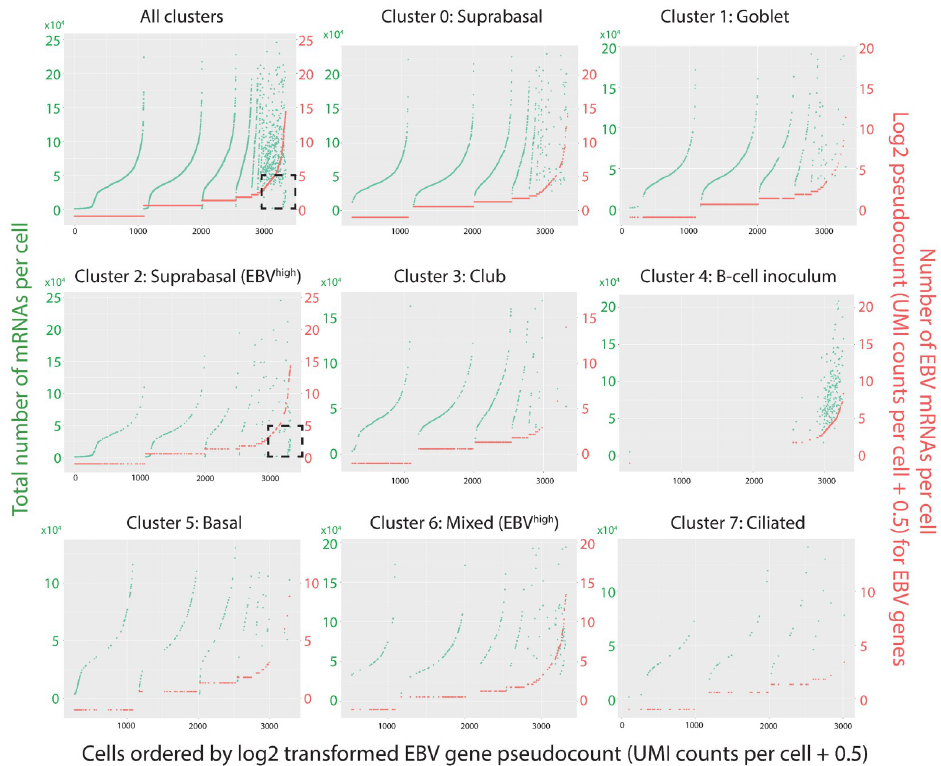
Fig 9. Comparison of EBV gene count to total number of mRNAs detected per cell. Shown are the results for the EBV-infected pseudo-ALI culture from donor no. 4. Dot plots show EBV gene pseudocount (red) and the total number of mRNAs (green) per cell. Each dot represents one cell. Cells are ordered by the EBV gene pseudocount on the x-axes. Data are organized by cluster. Dashed black box, denotes cells with high numbers of EBV transcripts (or mRNA molecules) but low total (host and viral) transcript counts representative of host shut-off. Only cells with > 1000 mRNAs per cell are shown as defined by the filtering criteria (see S1 Supplementary